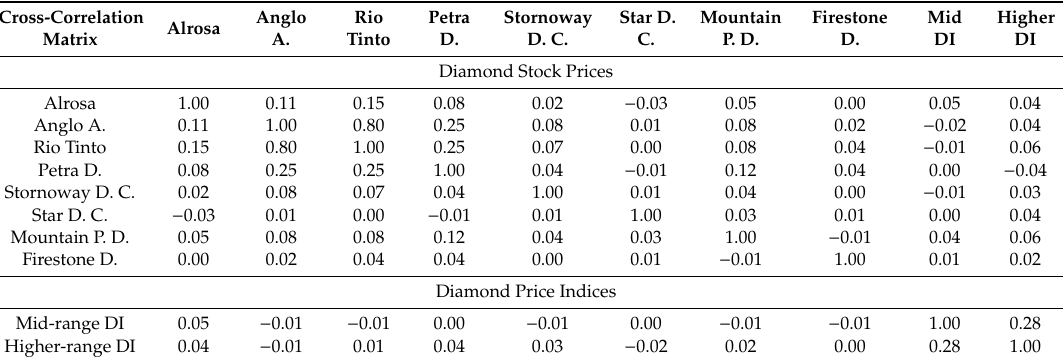
Table 8. Cross-correlation matrix among diamond-mining stocks and diamond price indices. Cross-Correlation